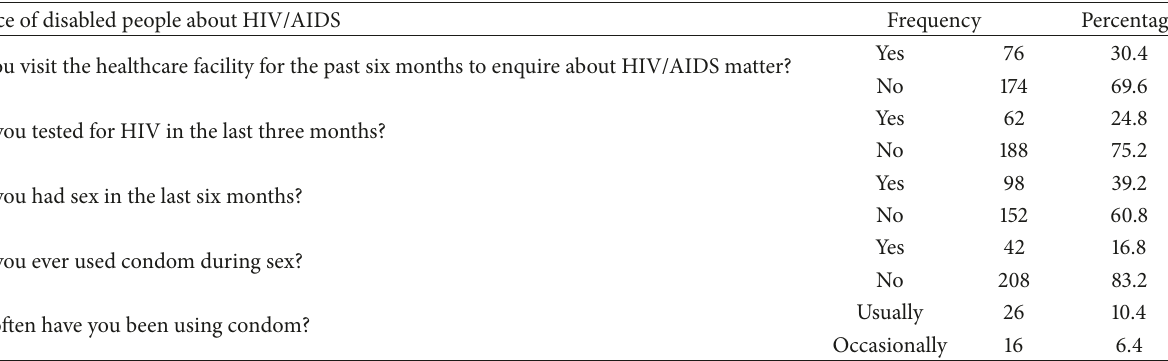
Practice of disabled people about HIV/AIDS Frequency